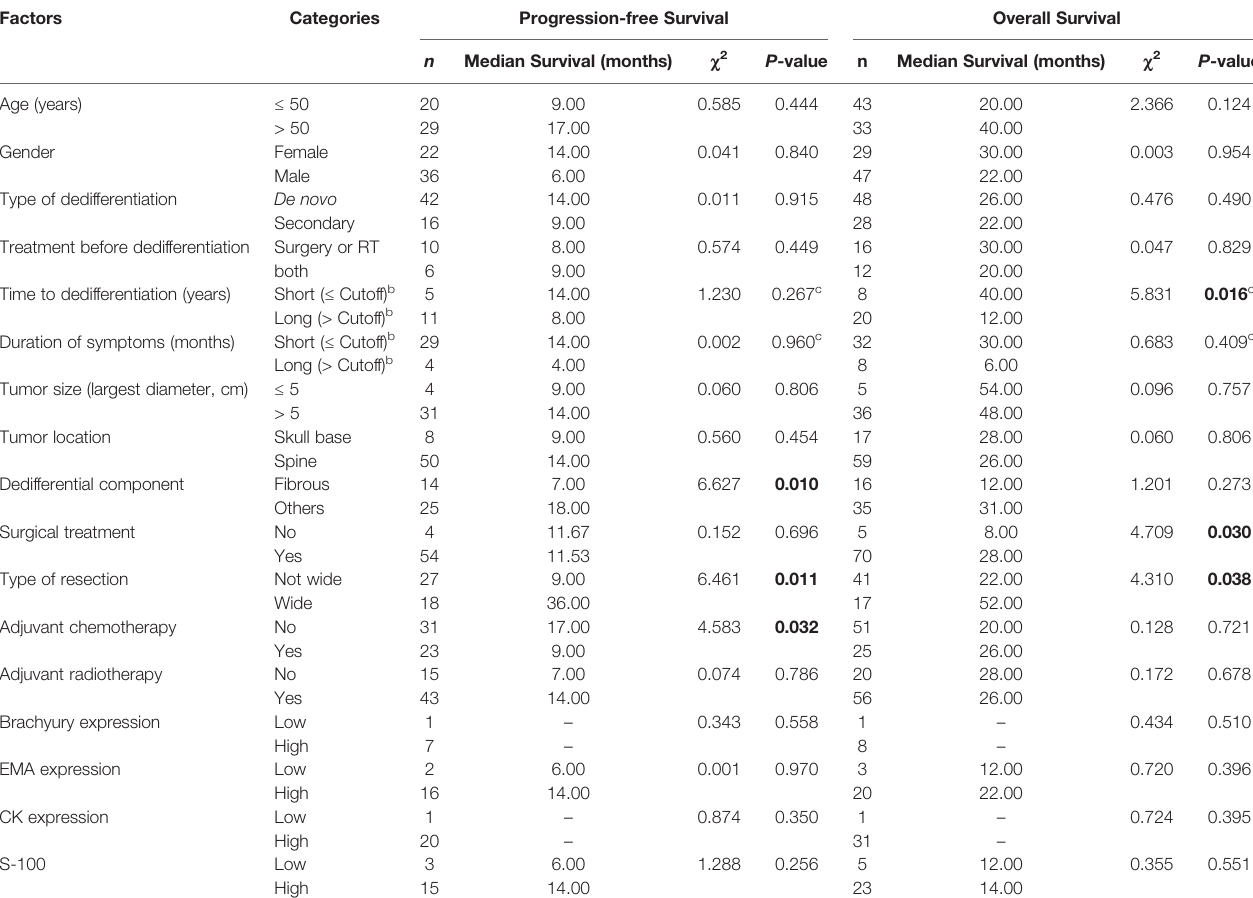
TABLE 4 | Univariate analyses of prognostic factors for progression-free survival and overall survival in patients with dedifferentiated chordoma a . Factors